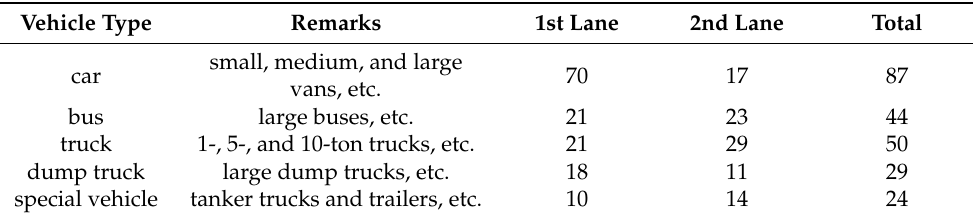
Table 4. Vehicle types that passed the bridge and their driving lanes in the ambient vibration test. Vehicle